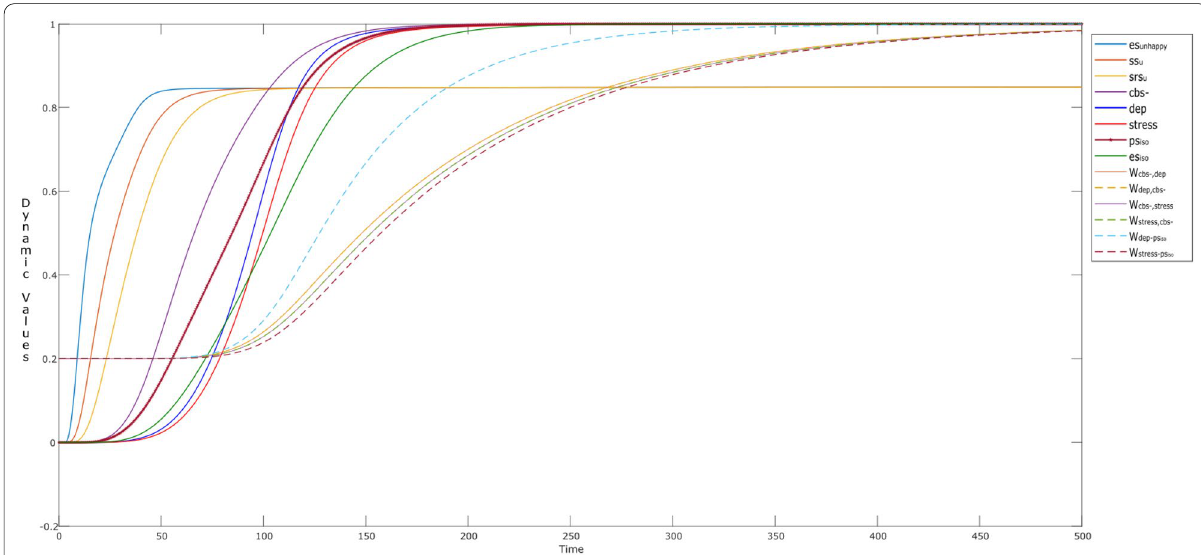
Fig. 9 Behavior of an isolated child after the narcissistic abuse (input: es unhappy